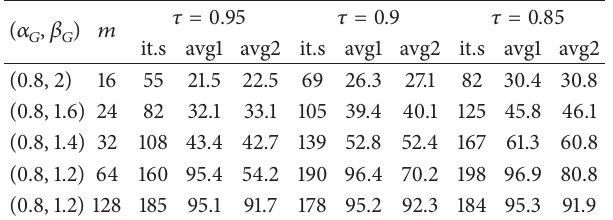
Table 6: Convergence results for IGPMHSS with 𝑃 1 = 𝑃 2 = 𝑊 . (𝛼 ,𝛽 ) 𝑚 𝐺 𝐺